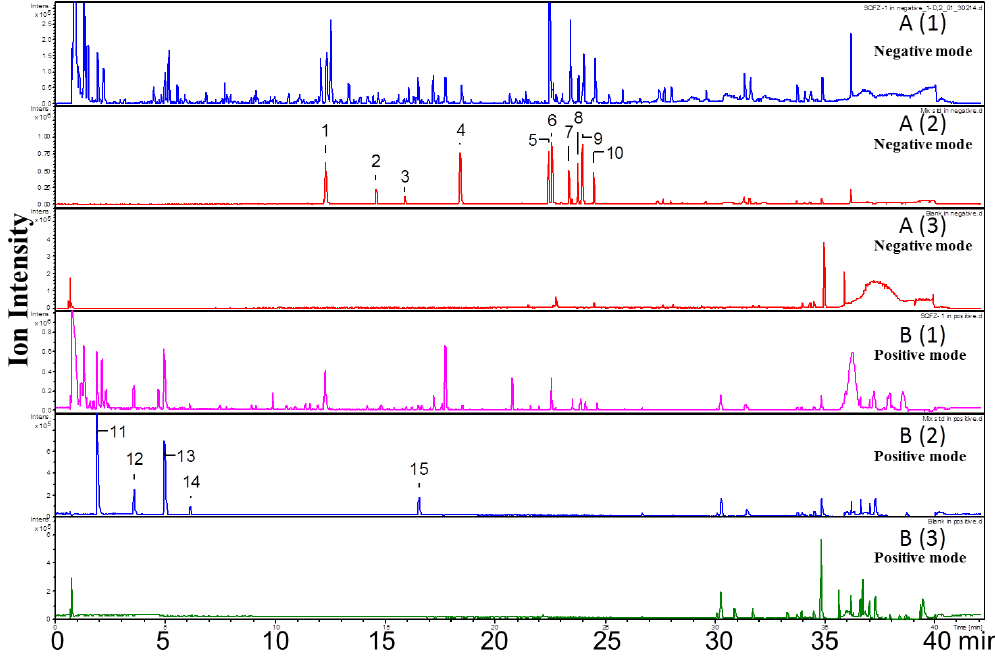
Figure 2. UHPLC-Q-Tof-MS chromatogram of SQI samples (A1 and B1), reference standards (A2 and B2), and blank samples (A3 and B3) in negative and positive ion mode.